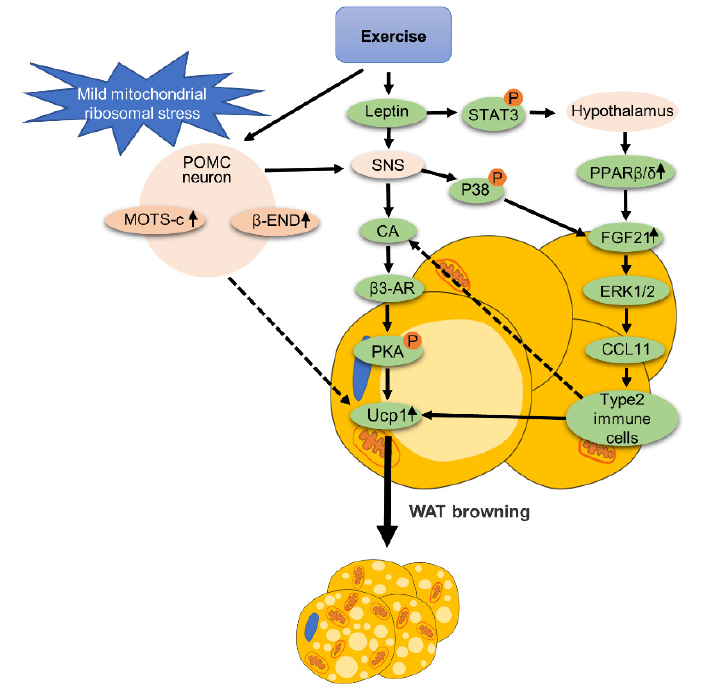
Figure 4. The role of the nervous system in exercise-mediated WAT browning. Exercise can increase the expression of β -endorphin ( β -END) and the mitochondrial open reading frame of the 12S rRNA-c (MOTS-c) in hypothalamic proopiomelanocortin (POMC) neurons, and mediate WAT browning. POMC neurons can stimulate SNS to mediate the browning of WAT. Exercise enhances leptin signaling in the nervous system, which can also activate SNS. After SNS is activated, it stimulates the release of catecholamines (CA). After the release of CA, it acts on β 3-adrenergic receptors ( β 3-AR) on adipocytes in WAT to stimulate PKA phosphorylation, thereby promoting the expression of Ucp1. In addition, leptin can stimulate phosphorylation of STAT3 in the hypothalamus to stimulate PPAR β / δ in eWAT, leading to the increased expression of FGF21. SNS activation also increases FGF21 expression by stimulating P38 signaling in WAT. The increased expression of FGF21 in adipocytes can activate ERK1/2 to promote the expression and secretion of the chemoattractant C-motif chemokine Ligand 11 (CCL11). CCL11 increases the level of type 2 immune cells in WAT. Type 2 immune cells are reported to stimulate CA release in WAT, which may be a possible mechanism for WAT browning.